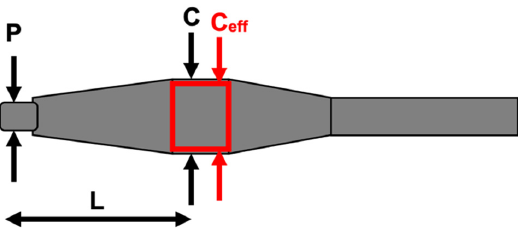
Figure A1. Geometric properties of the projectile affecting the cage armour efficiency.